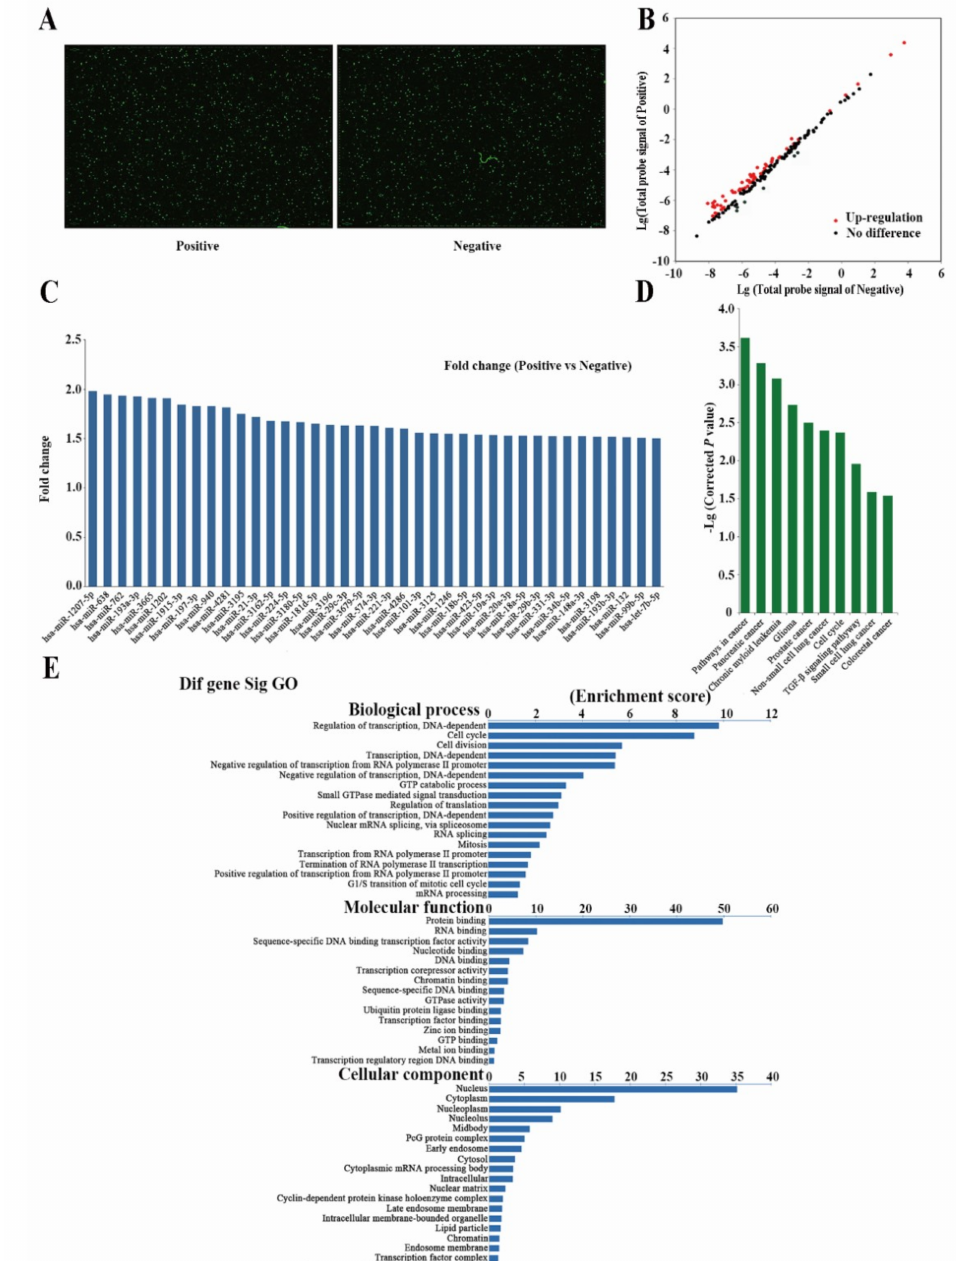
Figure4. Analysisofdi ff erentlyexpressedmiRNAsbetweentwosubpopulationsofcells. ( A )Expression map of microarray hybridization fluorescence. ( B ) Scatterplot of expression of miRNAs detected by microarray. ( C ) Di ff erently expressed miRNAs between the two subpopulations of cells. Detailed data are listed in Table S1. ( D ) Gene ontology (GO) analysis of the selected di ff erently expressed miRNAs. The selected miRNAs included hsa-let-7b, hsa-miR-18a, hsa-miR-18b, hsa-miR-19a, hsa-miR-20a-3p, hsa-miR-21-3p, hsa-miR-29b, hsa-miR-29c, hsa-miR-34b-5p, and hsa-miR-99b. ( E ) Common pathway analysis related to